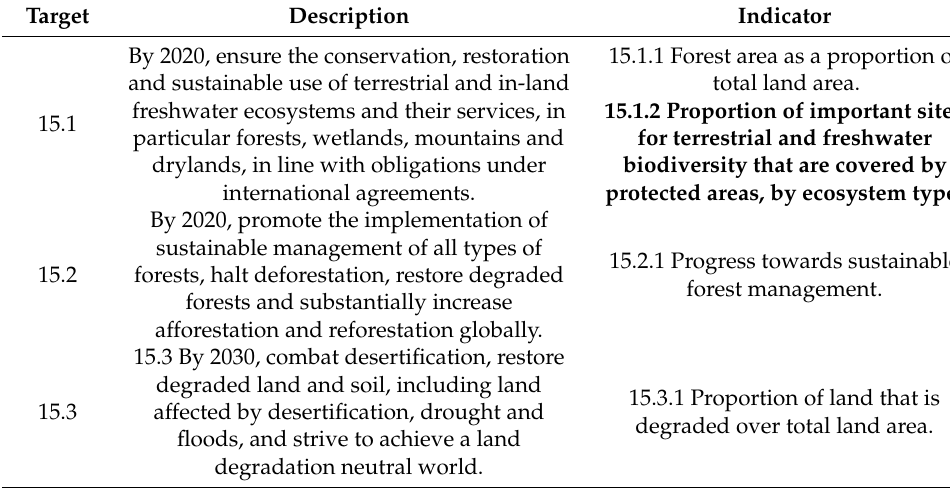
Table 1. Targets and Indicators under Sustainable Development Goal 15 (Life on Land) [33]. Indicators of particular relevance to this article are presented in bold font. Goal 15. Protect, Restore and Promote Sustainable Use of Terrestrial Ecosystems, Sustainably Manage Forests, Combat Desertification, and Halt and Reverse Land Degradation and